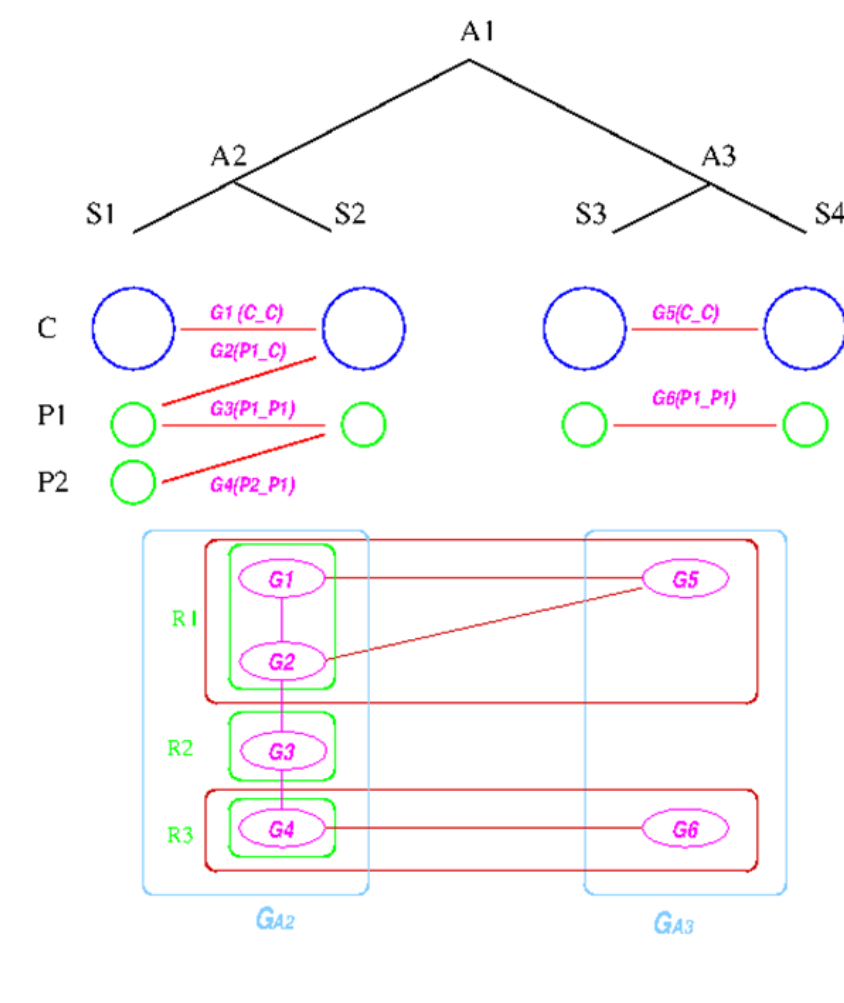
Figure 6. Replicon architecture reconstruction example. Blue circles represent main chromosomes, green circles plasmids, and purple ovals gene groups. Red boxes represent identified connected components in the group graph and green box final replicon architecture reconstruction